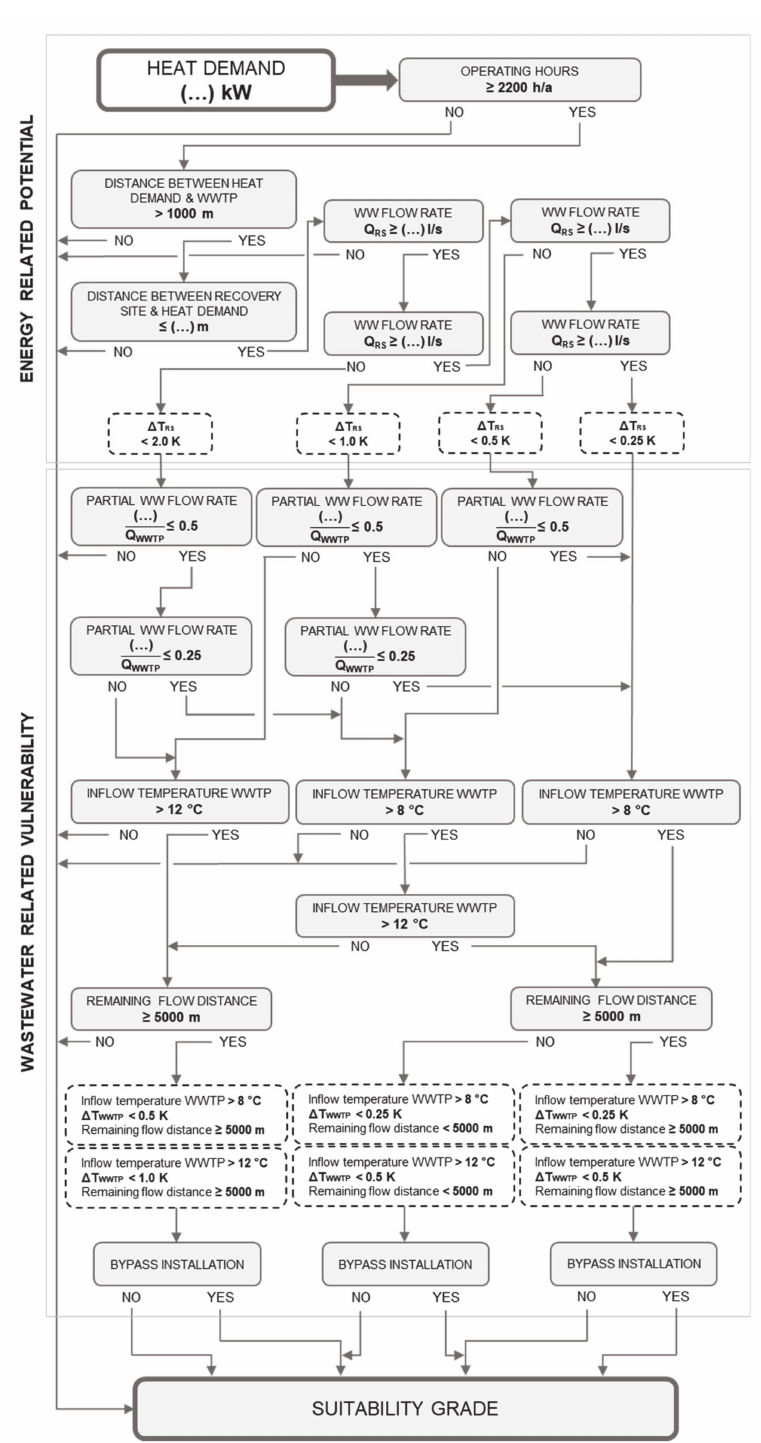
Figure 4. Overview on the theoretic relevance tree structure (own representation, based on